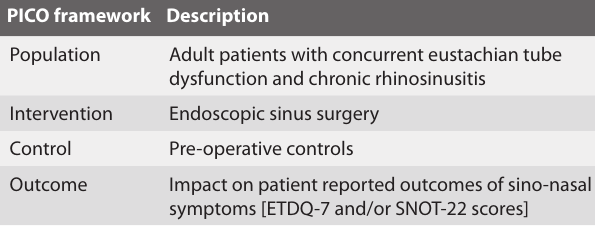
Table 1. PICO framework for systematic review and meta-analysis. PICO framework